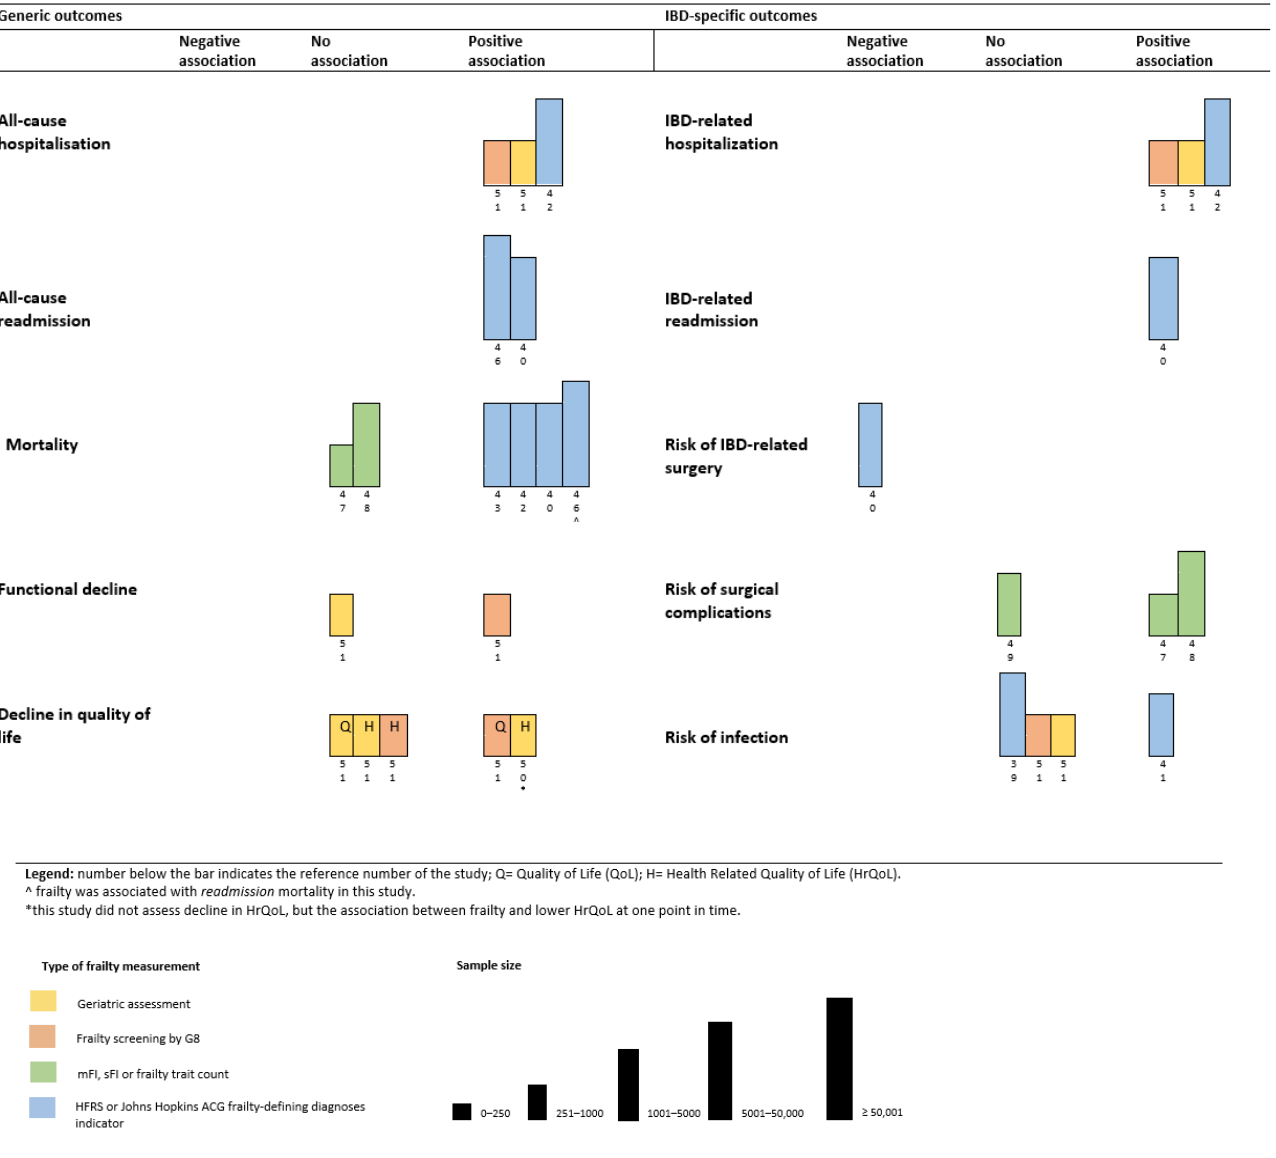
Figure 3. Harvest plot of the association between frailty and (1) generic outcomes and (2) IBD-specific outcomes.